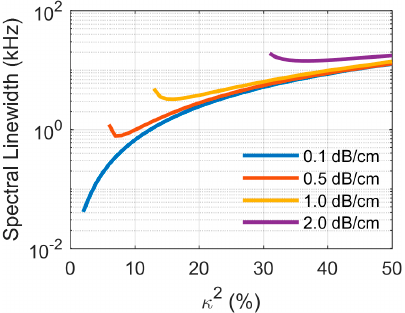
Figure 9. Simulated Lorentzian linewidth of widely-tunable laser comprising of three rings as a function of coupling strength of the high- Q ring for four waveguide propagation loss scenarios. The analysis ignores non-linear effects.